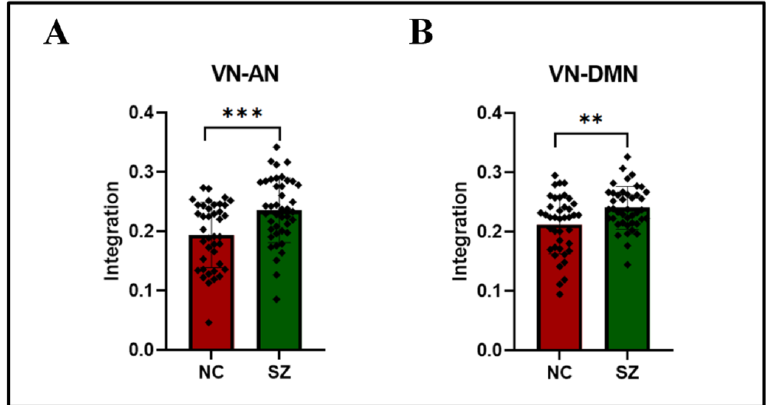
Table 4. RSN-to-RSN integration scores with significant differences in slow3 (0.073–0.198 Hz).